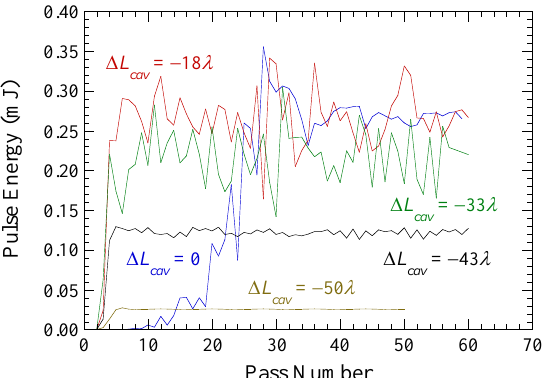
Figure 14. Temporal evolution of the pulse energy for cavity detunings of ∆ L cav = 0, − 18 λ , − 33 λ , − 43 λ and − 50 λ . The on-axis undulator field is B u = 6.658 kG ( K rms = 1.055), while the other parameters are given in Table